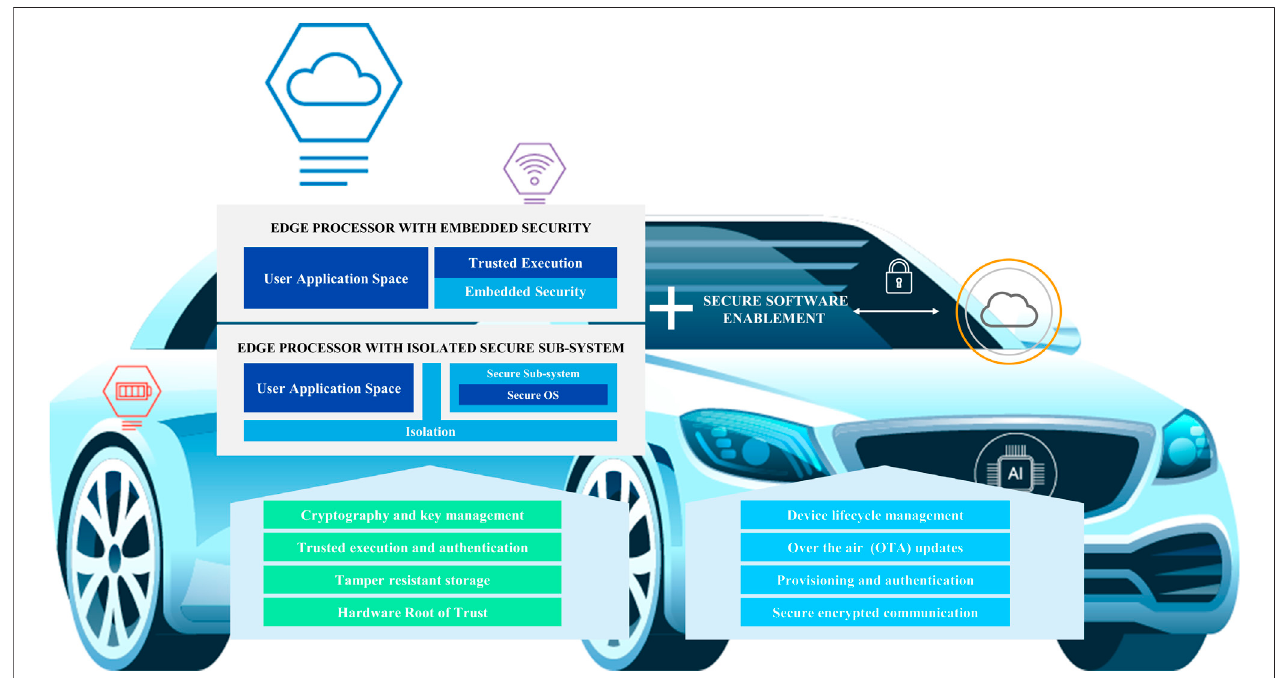
FIGURE 10 | Information security and privacy issues for ECAS